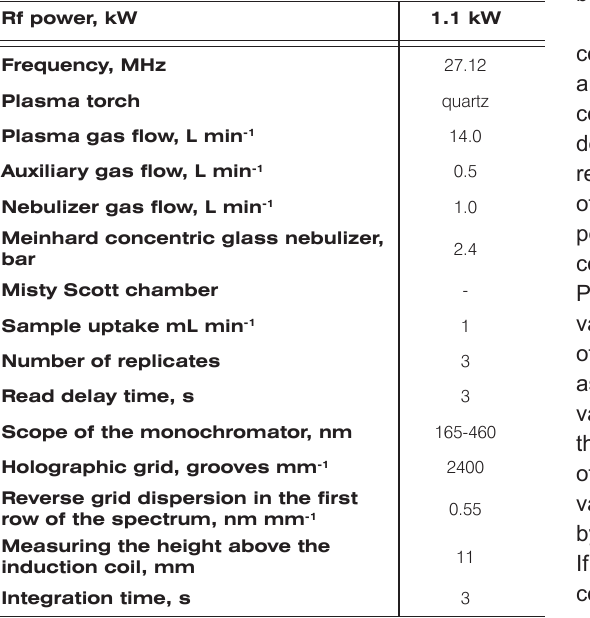
Table 2. Wavelength, limits of detection and quantification of elements in µg mL -1 and µg g -1 dry